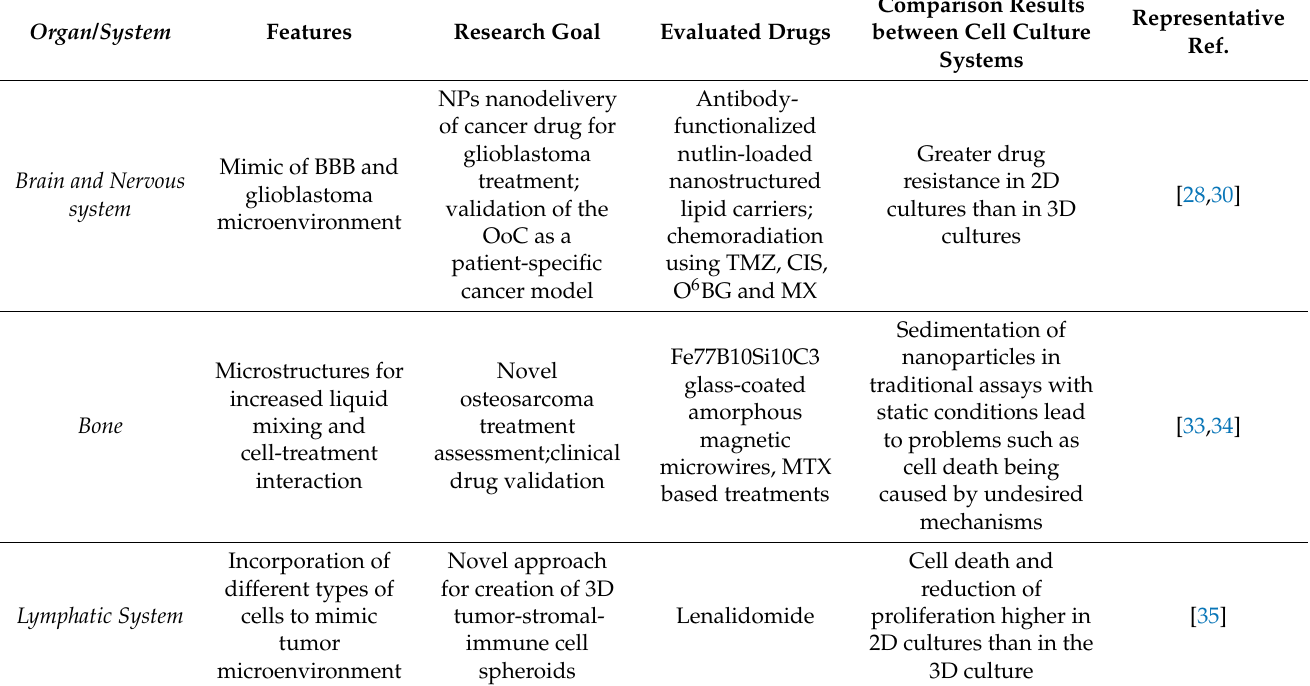
Table 1. Features and comparison results between cell culture systems presented on representative references by organ